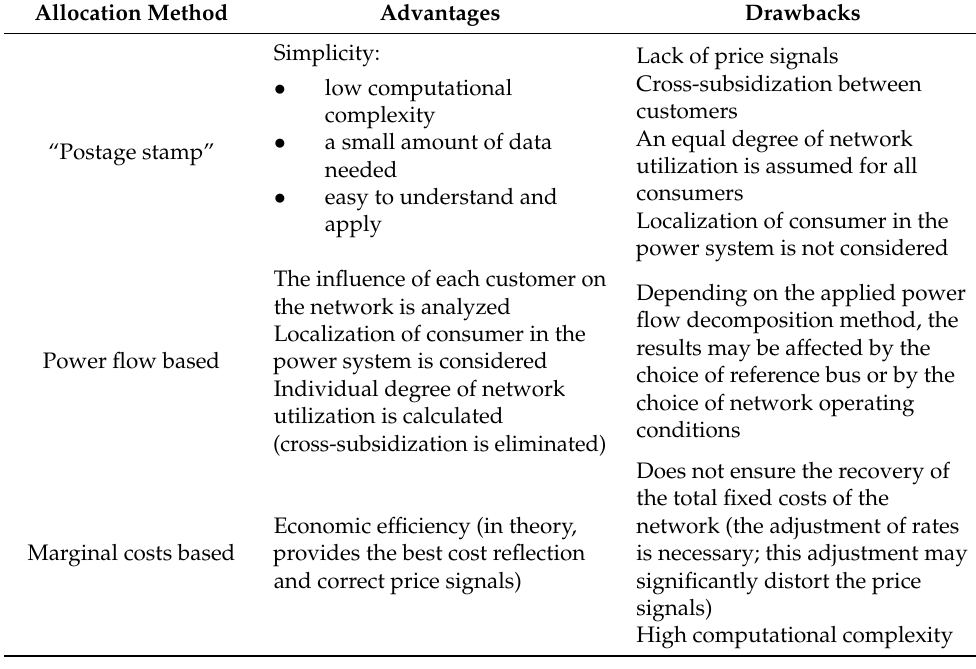
Table 2. Major advantages and drawbacks of various fixed costs allocation